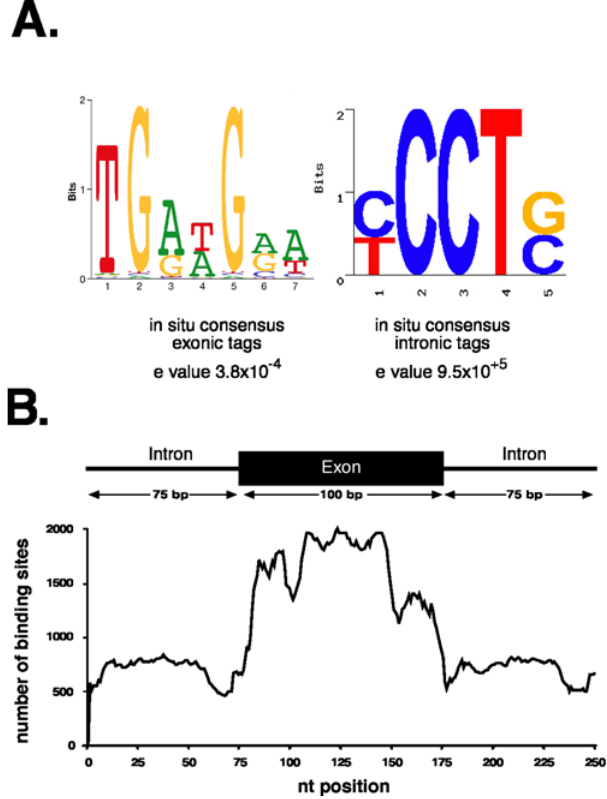
Figure 3. Identification of the SF2/ASF consensus binding site and its frequency distribution in coding exons and